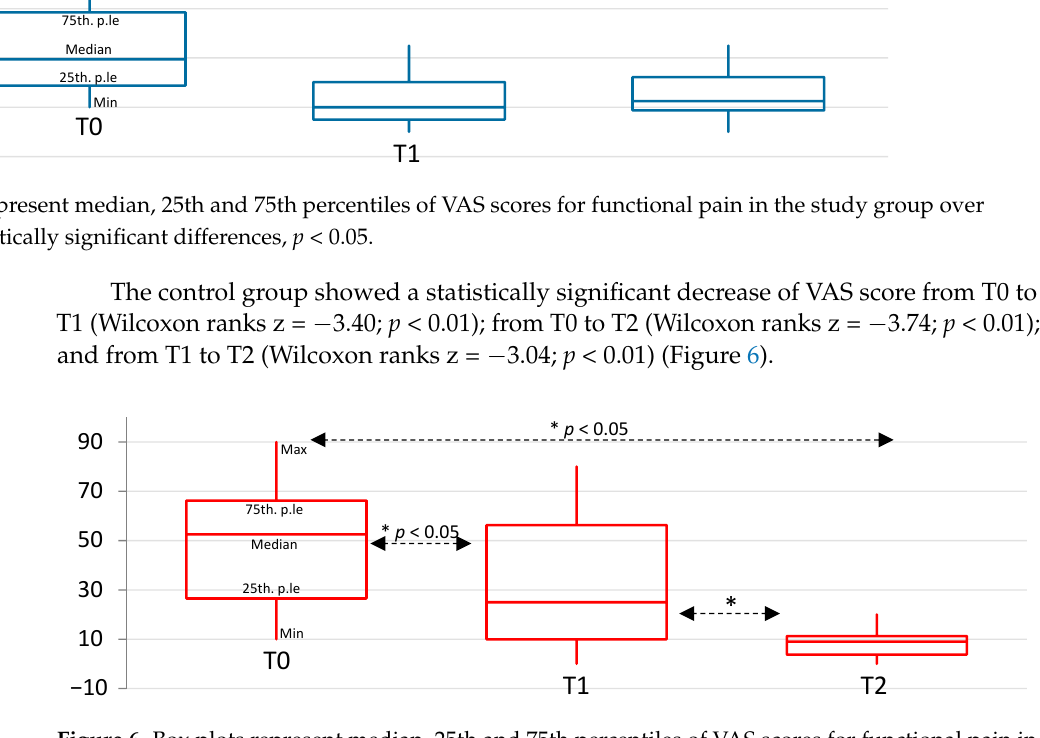
Figure 6. Box plots represent median, 25th and 75th percentiles of VAS scores for functional pain in the control group over time. * indicates statistically significant differences, p < 0.05.